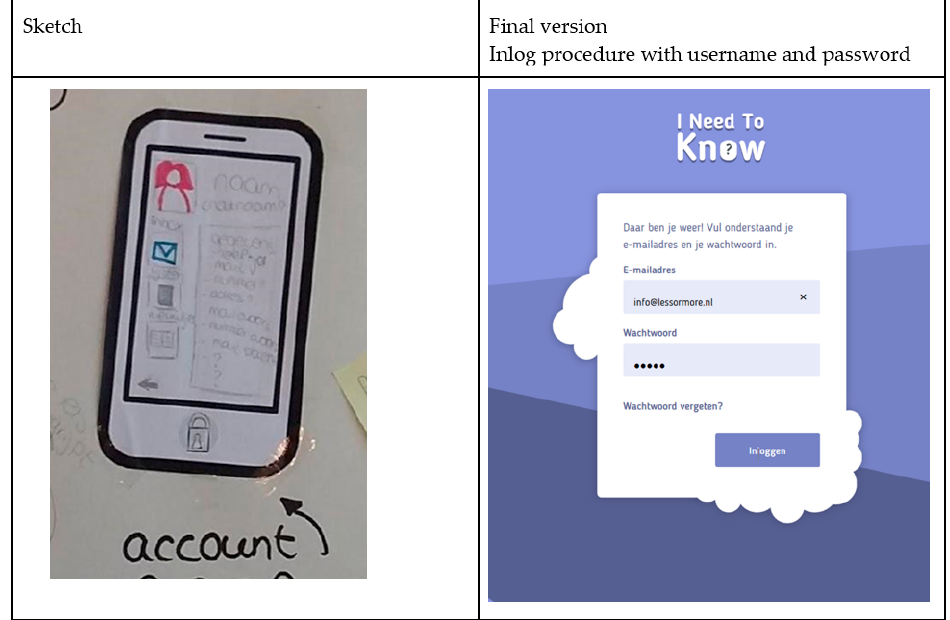
Figure 8. Privacy and Safety: Accounts are only accessible by youngsters.